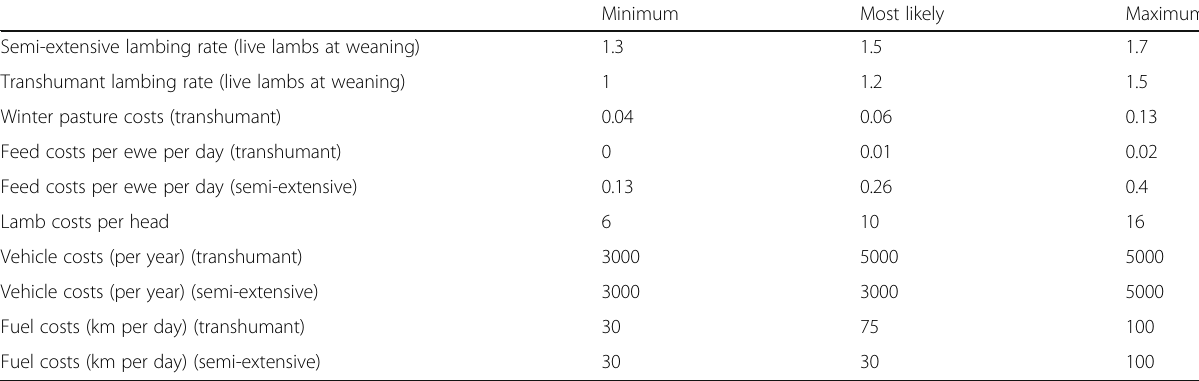
Table 4 Parameter estimates used in the Monte Carlo